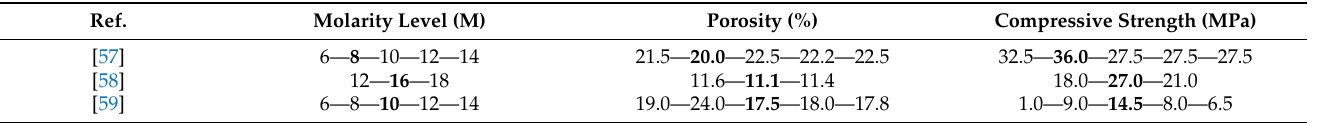
Table 4. Influence of alkali molarity on porosity and strength of geopolymer cement, according to several literature data (optimal values in each study are shown in bold).